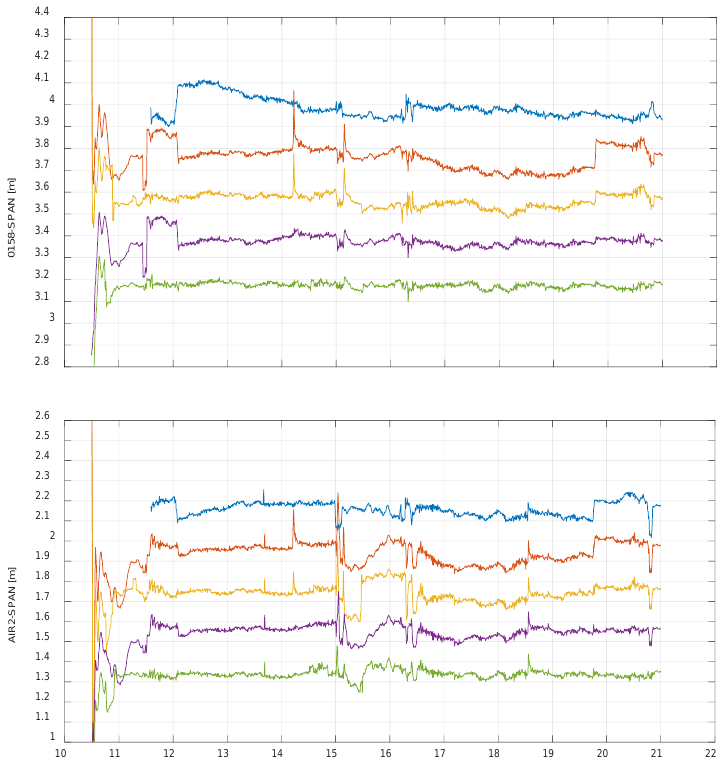
Figure 8. The time series of baseline length of the three antennas derived from DD, PPP and POP approaches. Both the float as well as fixed solutions are shown for PPP and POP. For clarity, the DD, PPP float, PPP fixed and POP float results are shifted by 0.2, 0.4, 0.6 and 0.8 m, respectively.